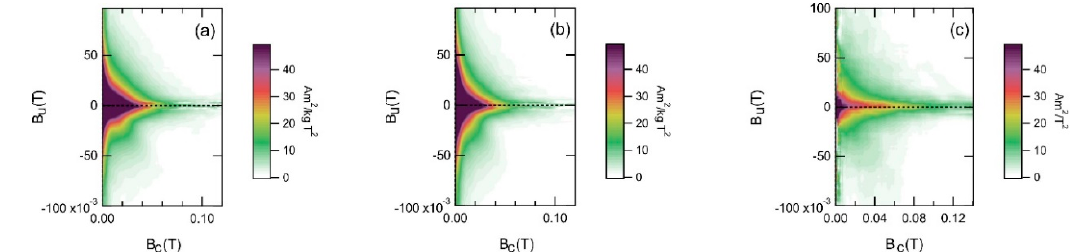
Figure 12. Example of the first-order reversal curve (FORC) diagrams for the street dust fraction of grain diameter between 0.1 and 0.071 mm ( a , b ) and particulate matter (PM) ( c ). Smoothing factors for street dust: S c 0 = 4, S b 0 = 3, S c 1 = S b 1 = 4, and λ = 0.1: single domain (SD) 9 ( a ) and SD 14 ( b ). FORC diagram of a representative sample of PM (ap-258). Smoothing parameters for PM: S c 0 = 4, S b 0 = 6, S c 1 = S b 1 = 10, and λ = 0.08. It should be noted that PM is not mass-normalized.